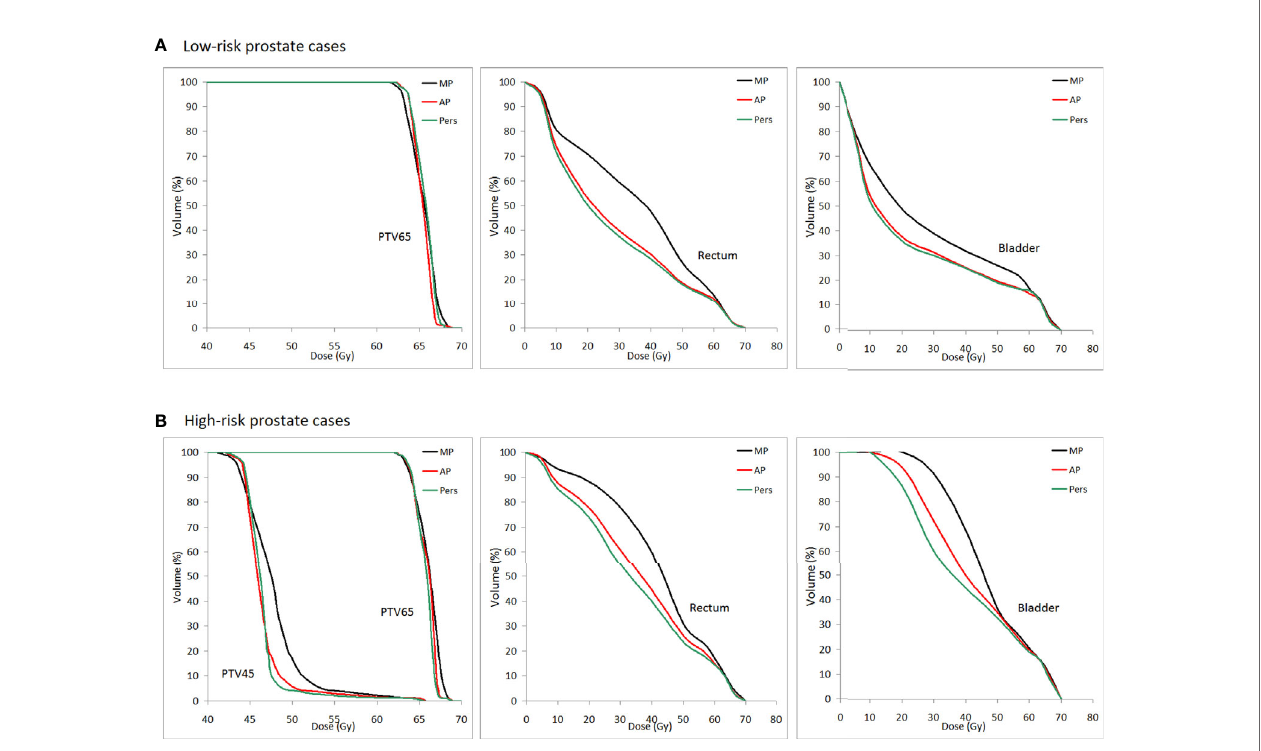
FIGURE 5 | Population mean DVHs for PTV65, PTV45, rectum, and bladder for (A) low-risk and (B) high-risk prostate cancer patients (MP plans: black-solid line, AP plans: red solid-line, and Pers plans: green solid-line).